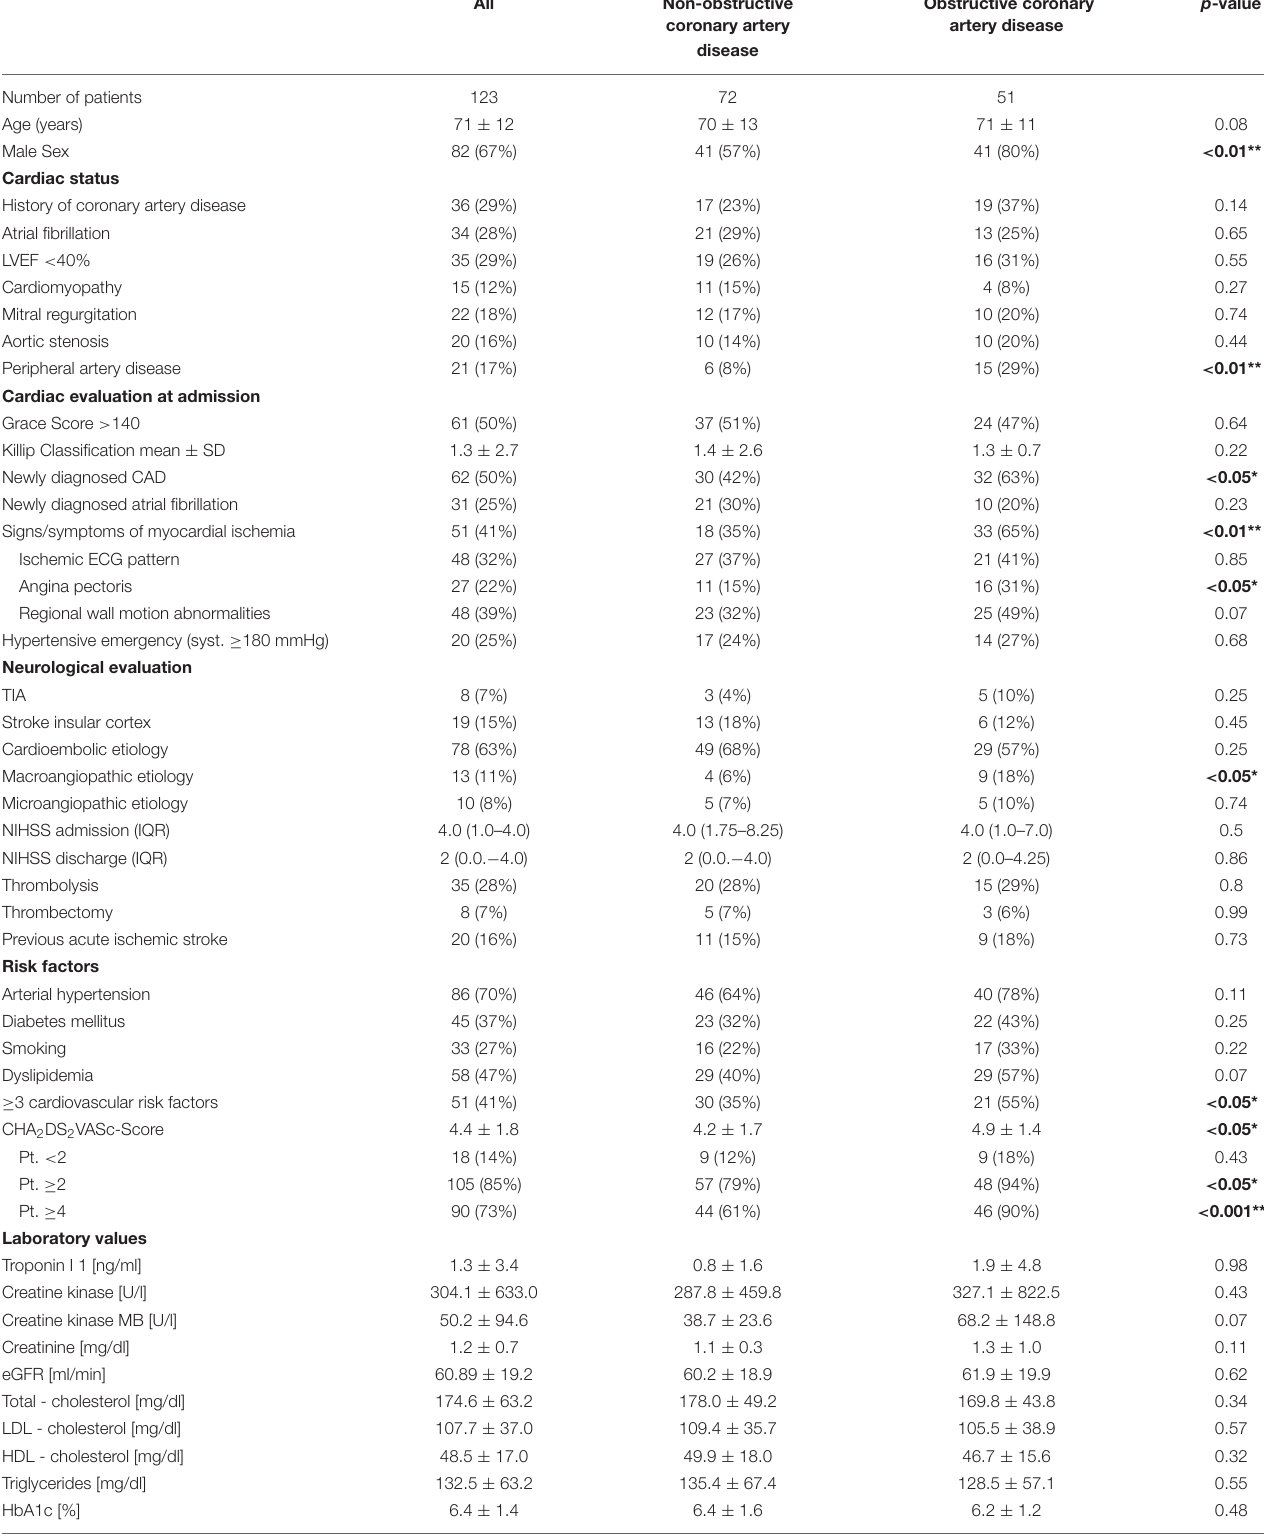
TABLE 1 | Baseline characteristics.